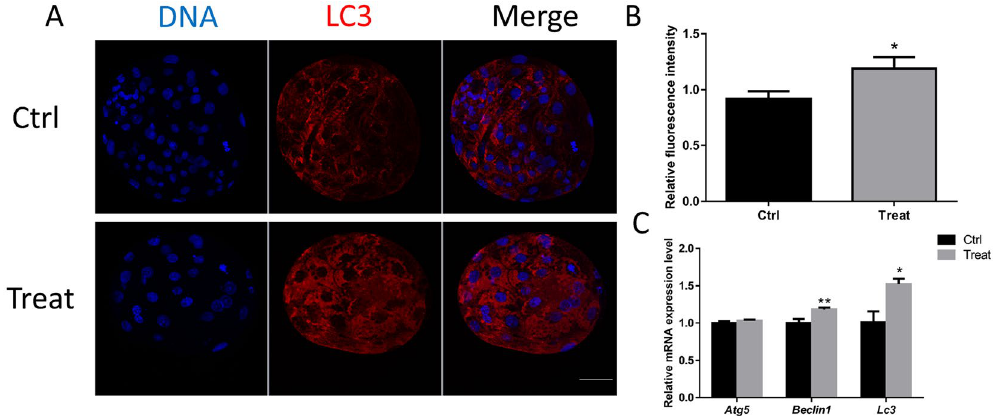
Figure 6. Effect of BPA exposure on autophagy. ( A ) Laser scanning confocal microscopy images of immunostaining for the LC3 protein in porcine blastocysts with or without BPA. ( B ) Relative fluorescence intensity of LC3. ( C ) Relative mRNA expression levels of autophagy-related genes, Atg5 , Beclin1 , and Lc3 . * P < 0.05, ** P < 0.01. Ctrl, control; Treat, treatment. Scale bar: 50 μ